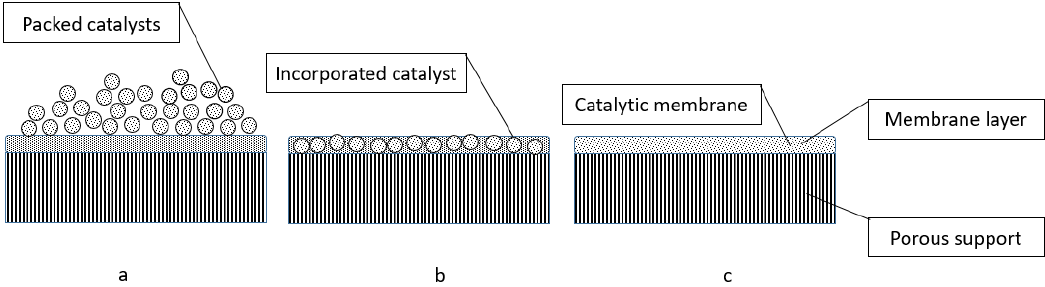
Figure 9. The two membrane reactor types: ( a ) packed bed membrane reactor; ( b , c ) catalytic membrane reactors.